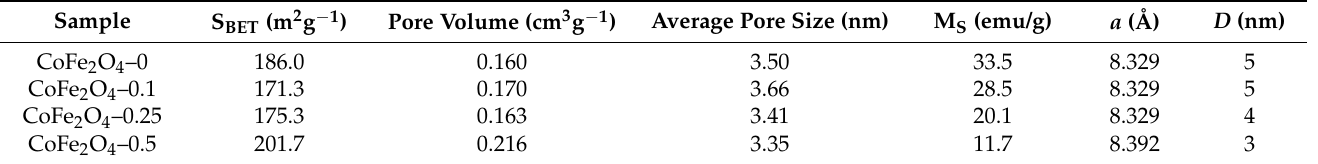
Figure 4. X-Ray diffractograms of CoFe 2 O 4 samples. Table 1. Textural, magnetic properties, lattice parameters and mean size of CoFe 2 O 4 samples.